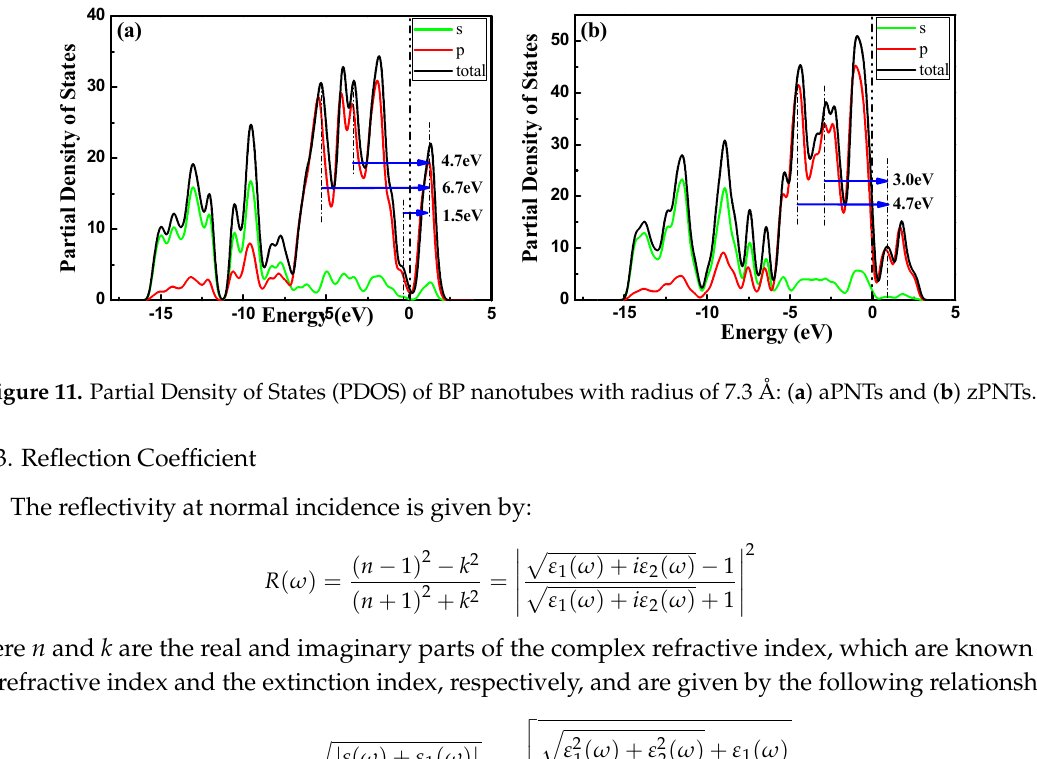
Figure 10. Absorption coefficient of BP nanotubes with electric field direction parallel to the radius. ( a ) aPNTs with different radii; ( b ) aPNT and zPNT with a radius of 7.3 Å, and ( c ) aPNT and zPNT with a radius of 11.5 Å.